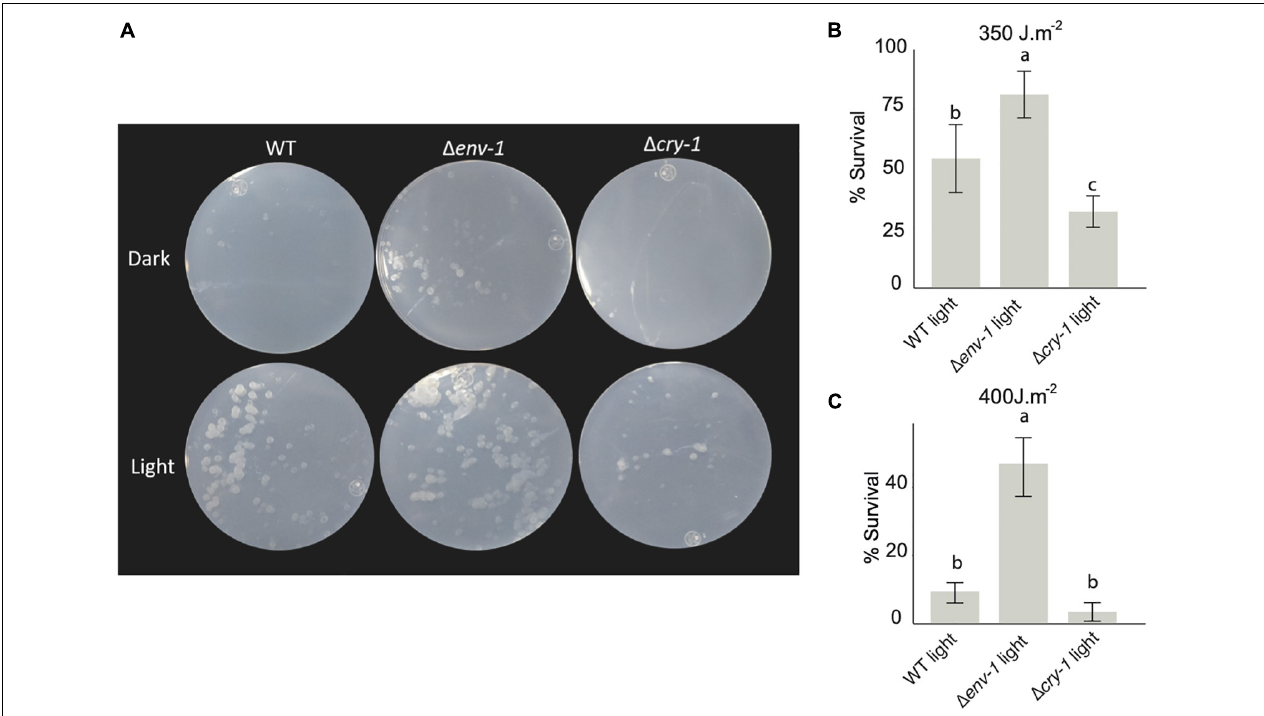
FIGURE 6 | env -1 mutation has a positive effect on photoreactivation. (A) Colonies of the WT strain and the (cid:49) cry -1 and (cid:49) env -1 mutants incubated for 48 hours in constant light and dark conditions after being irradiated with 350 J · m − 2 or 400 J · m − 2 UV-C light. (B,C) Survival of the colonies of the photoreactivated strains at 350 J · m − 2 (B) or 400 J · m − 2 (C) . Colonies were counted after incubation in light and the results were represented as percent survival for each condition relative to the control not irradiated with UV-C light. One-way ANOVA (Tukey’s Post Hoc Test with 95% confidence interval) was used for each condition. Bars show means ± SD. The letters above each bar indicate statistically significant differences ( P < 0.05; n =